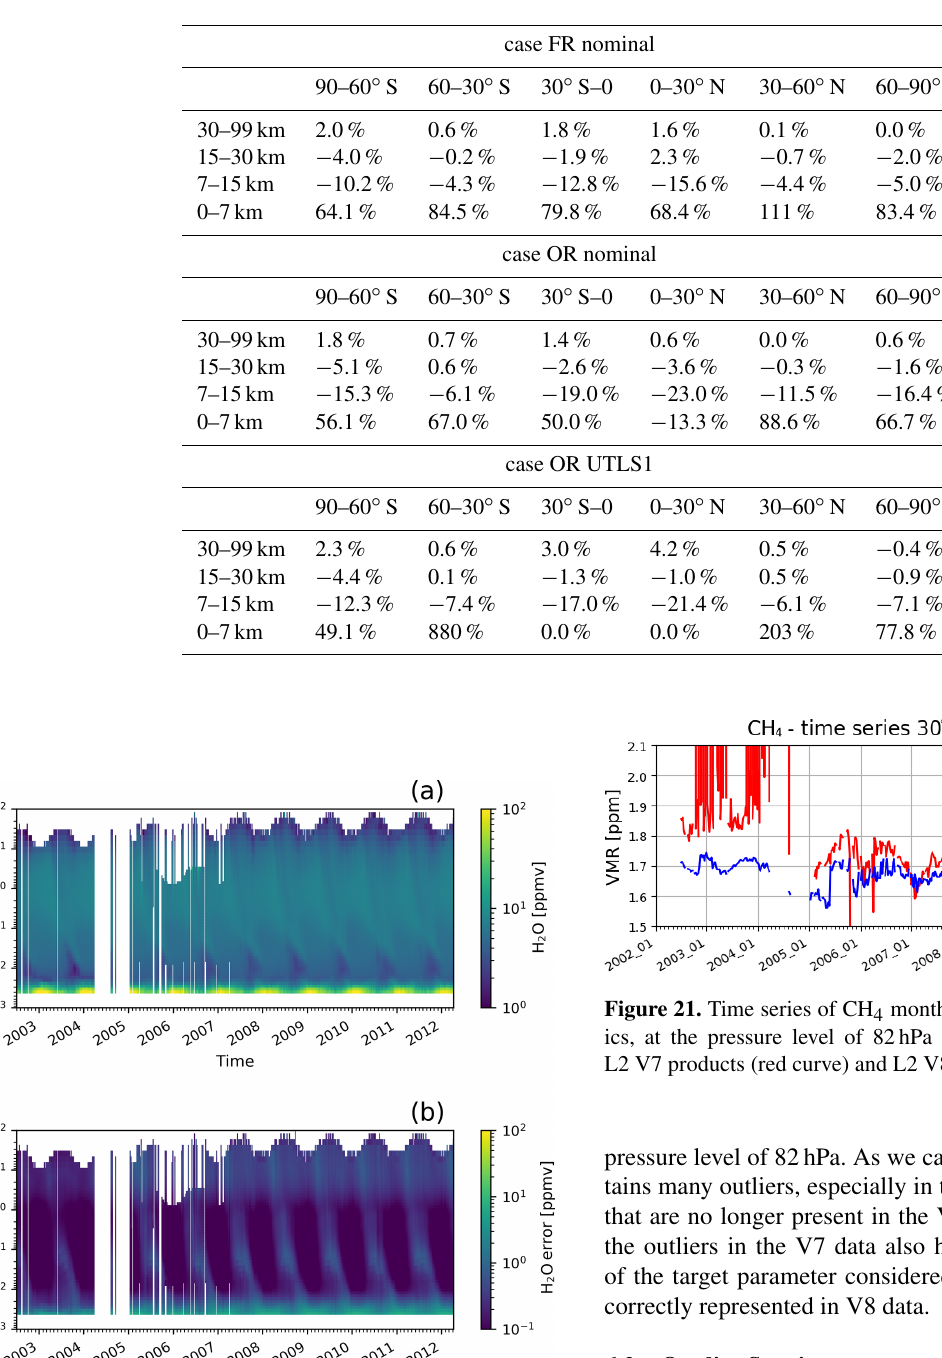
Table 2. Percentage differences in the number of temperature profile grid points retrieved with the V8–V7 CI thresholds. The statistics are given, separately, for four height ranges and six latitude bands. They include a sample of ≈ 4000 orbits acquired in nominal (both FR and OR) and UTLS-1 modes.